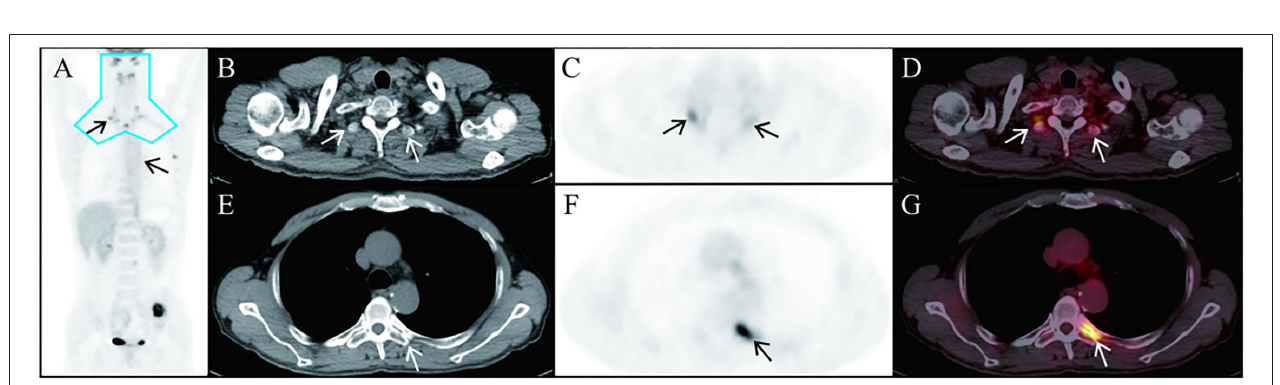
FIGURE 1 | As shown in MIP of 18F-FDG PET, 18F-FDG uptake in the petrous part of right temporal bone [ (A) , arrows], right foramen magnum, right four anterior ribs, left five lateral ribs and posterior ribs, left eight posterior ribs [ (A) , arrows], left pedicle of Lumbar 3 vertebral body [ (A) , arrows], and bilateral ilium [ (A) , arrowhead] are revealed and characterized with osteolytic bone destruction. Axial CT, PET, and fusion PET/CT images of representative involve bone lesions, including the petrous part of right temporal bone [ (B–D) , arrows; SUVmax, 20.3] and bilateral ilium [ (E–G) , arrowhead; SUVmax, 20.3], which are exhibited. In addition, the image shows the 18F-FDG uptake in the abdominal lymph nodes peri-pancreatic, indicating pheochromocytoma metastasis [ (H–J) , arrow; SUVmax, 5.2].